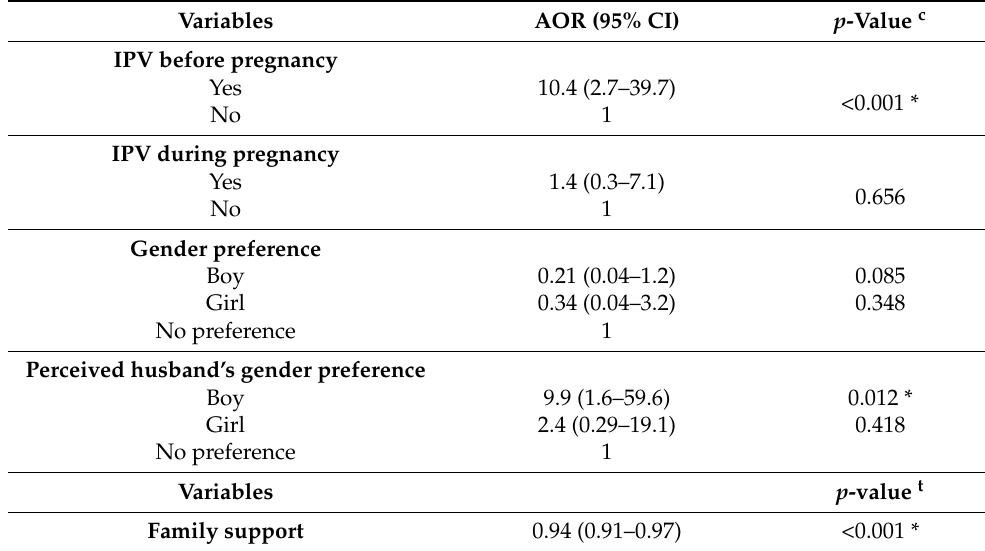
Table 3. Multivariate logistic regression model showing associated factors of antenatal depressive symptoms among pregnant women in MAA health camps in rural